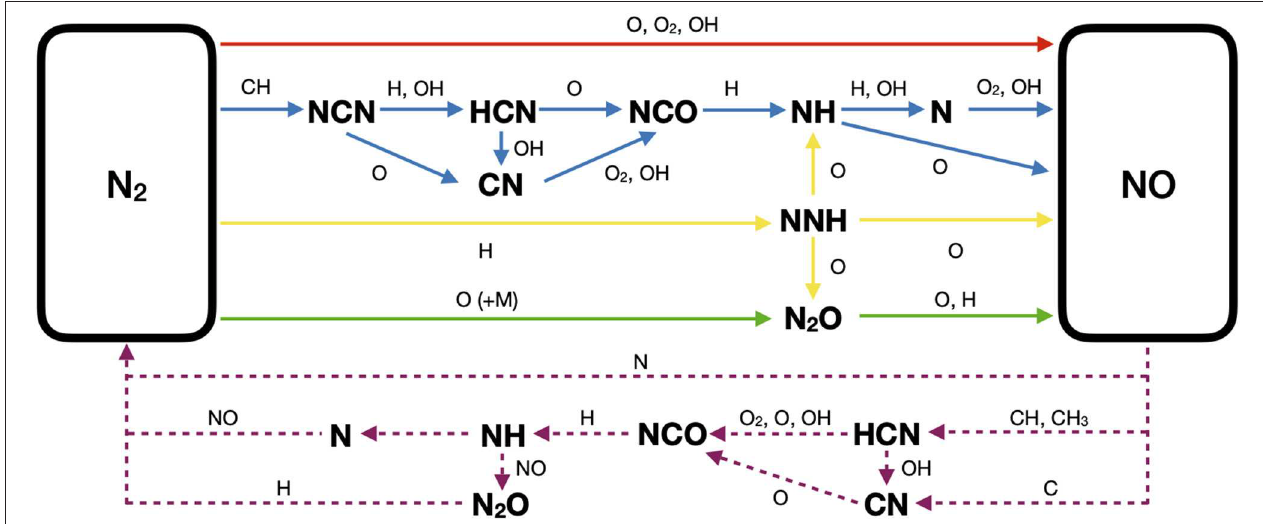
FIGURE 1 | Simplified scheme of formation and destruction pathways of the NO species: thermal (red solid arrow), prompt (blue solid arrows), N 2 O-intermediate (green solid arrows), NNH-intermediate (yellow solid arrows), and reburning (purple dashed